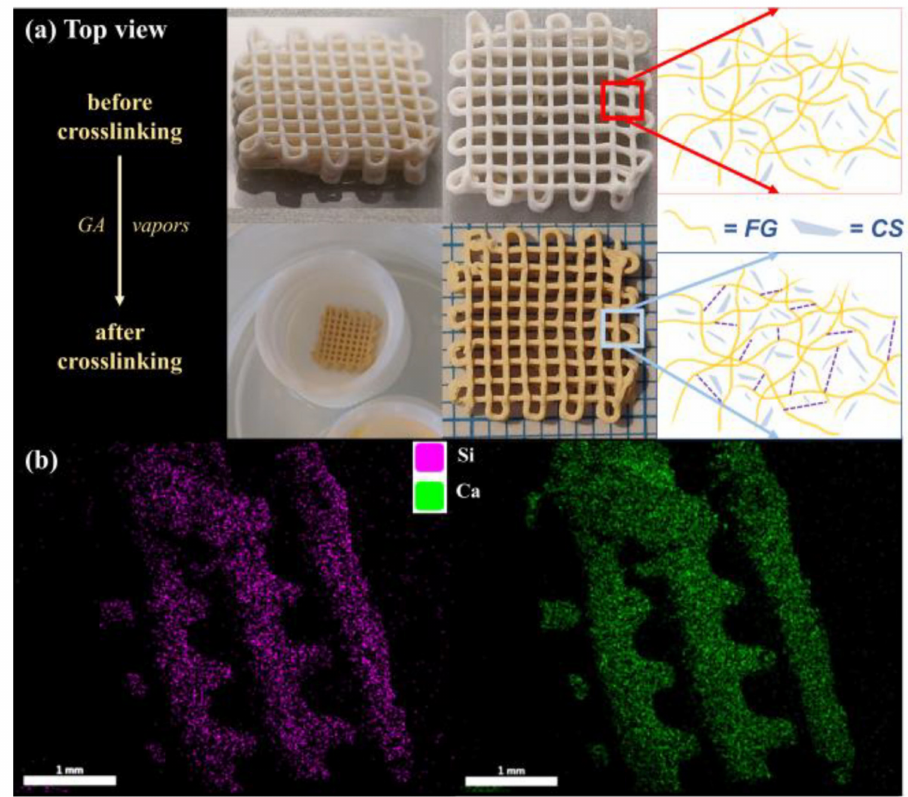
Figure 3. ( a ) Digital images revealing the top view of the CS–FG3 sca ff olds and the schematic representation of the components, before and after the crosslinking process; ( b ) the SEM / EDX micrographs of the crosslinked CS–FG3 sca ff old suggests a homogeneous distribution of CS in the gelatin